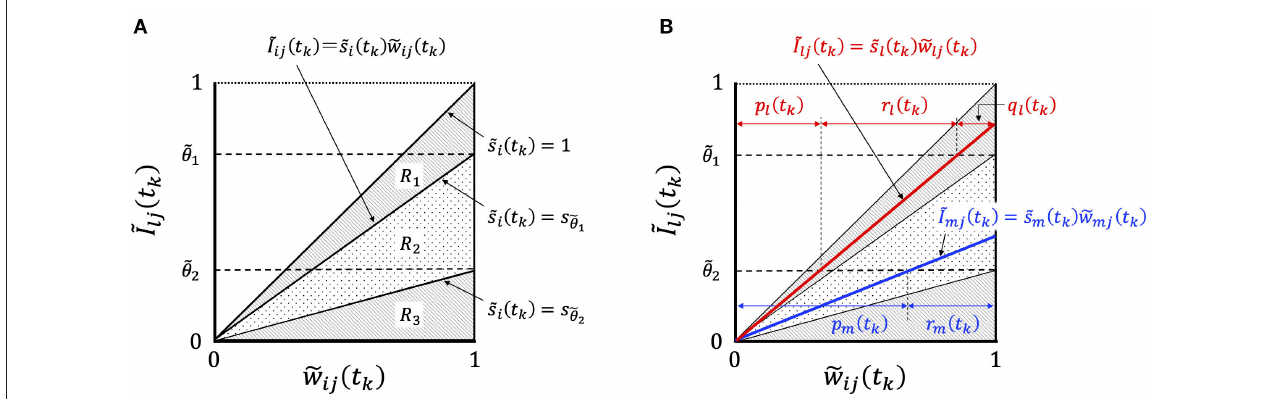
FIGURE 4 | Graphical representation of synaptic weight changes by the STLR algorithm. (A) Region R is partitioned into three regions depending on the magnitude of ˜ s i ( t k ); R 1 consists of three regions of “enhancement,” “invariance,” and “attenuation,” R 2 of two regions of “invariance” and “attenuation” and R 3 of one region of “attenuation.” (B) The relationship between the synaptic weights ˜ w ij ( t k ) and ˜ I ij ( t k ) in Equation (20). In the case of the relation belonging to the region R 1 shown by red line, the weight change has “enhancement,” q l ( t k ), “invariance,” r l ( t k ), and “attenuation,” p l ( t k ). The weight vector ˜ W l ( t k ) is trained in the direction of reducing the difference between the weight vector and the input vector according to the magnitude of q l ( t k ). In the case of the relation belonging to the region R 2 , as shown by blue line, the weight change has “invariance,” r m ( t k ), and “attenuation,” p m ( t k ). The weight vector ˜ W m ( t k ) is not trained and remains